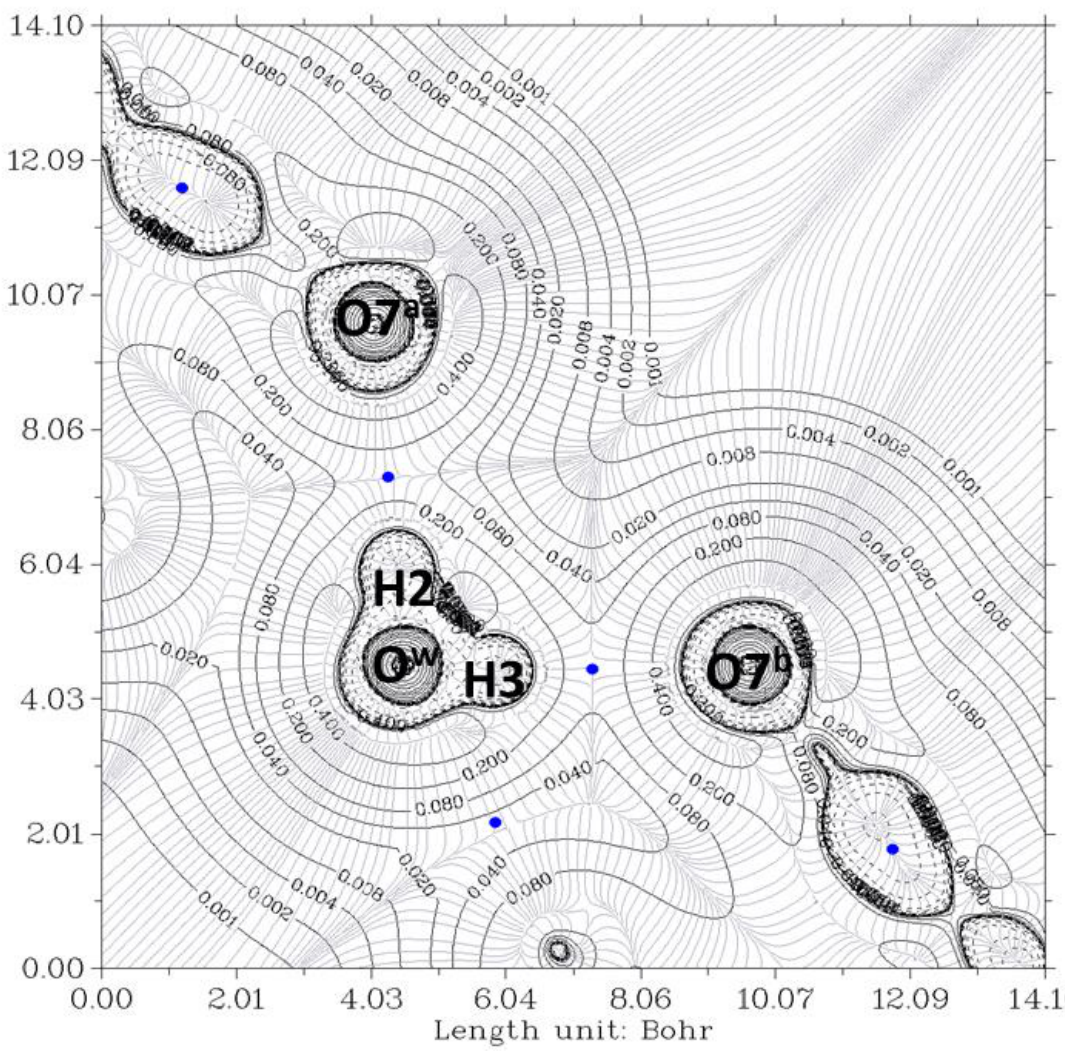
Figure 3. The electron density contour of the O 12a -H … O w -H ... O 7a //O 12b -H … O w -H ... O 7b complex (thin black lines) and BCP (3,-1) (blue dots). The plane is defined by O 7a , O 7b , and O w oxygen atoms of the pseudo-bile acid residues and water, respectively. Thin gray lines correspond to the gradient of the electron density.